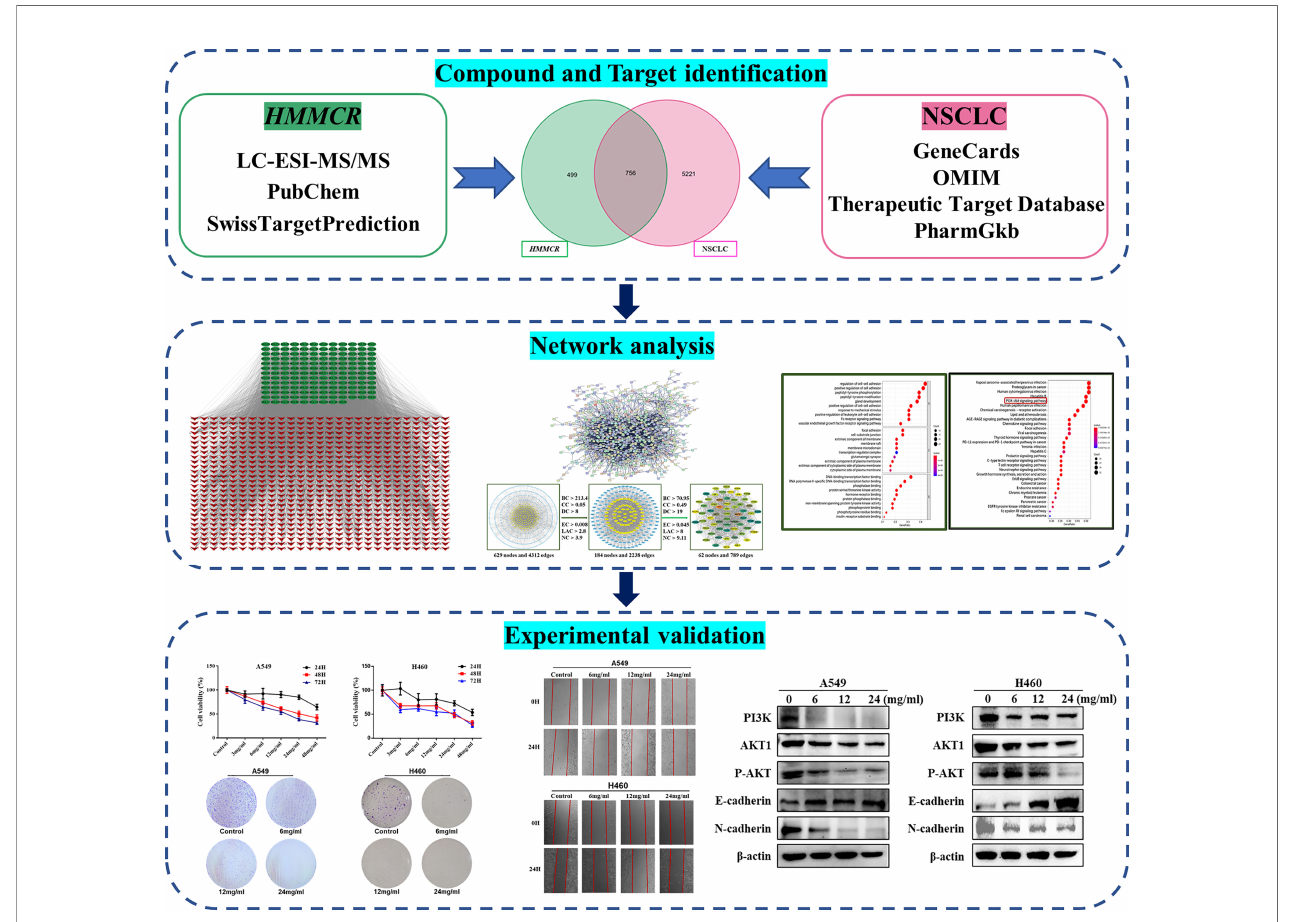
FIGURE 1 | The framework and detailed idea of this